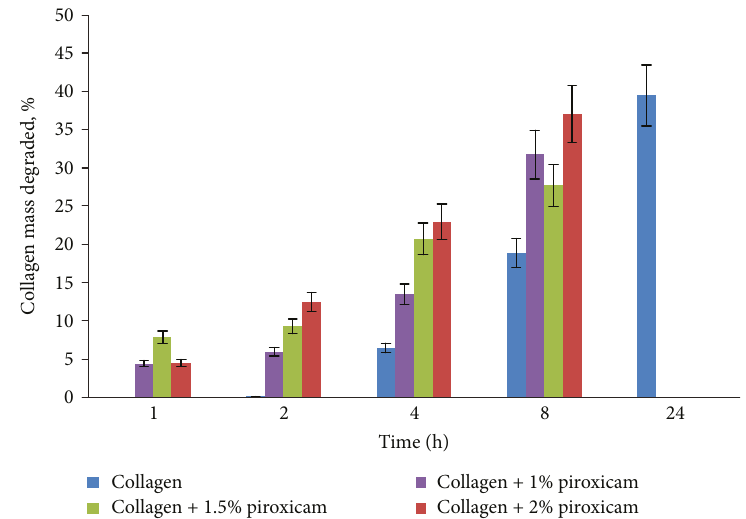
Figure 2: Enzymatic degradation of piroxicam sponges.